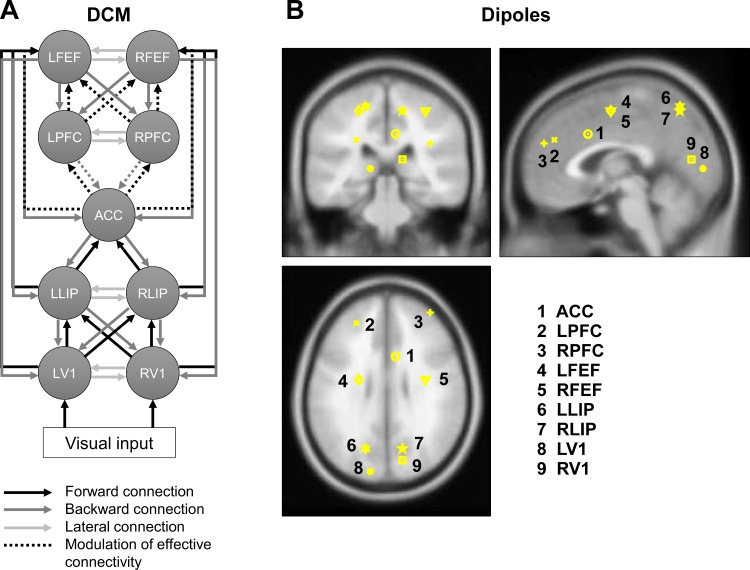
Effective connectivity model tested in a DCM analysis and equivalent current dipole locations.A The neuronal sources in the model are connected with forward (black), backward (dark grey) or lateral (light grey) connections. Connections that are modelled to vary between experimental conditions are depicted with dotted lines. Connections between V1 and FEF as well as LIP and FEF also connect to the contralateral side but are depicted only for the ipsilateral side for the sake of clarity of the figure. B Locations of the equivalent current dipoles included in the model are depicted in an MRI of a standard brain in MNI space. ACC, Anterior cingulate cortex; LFEF/RFEF, left and right frontal eye field; LLIP/RLIP, left and right lateral intraparietal area; LPFC/RPFC, left and right prefrontal cortex; LV1/RV1, left and right primary visual cortex.